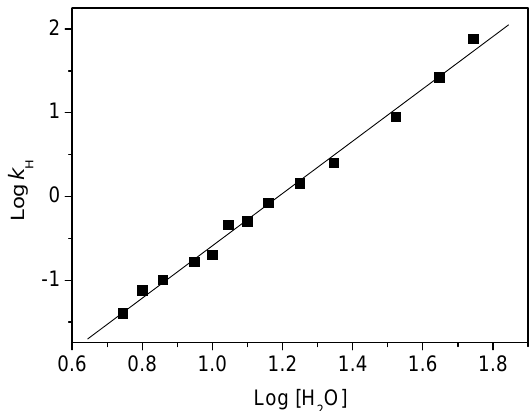
Figure 4. Variation of the rate constant k (in ns -1 ) of protonation by water of the 44BPY - H anion radical as a function of the water concentration (in M) in acetonitrile-water solvent mixtures (DABCO concentration of 0.5